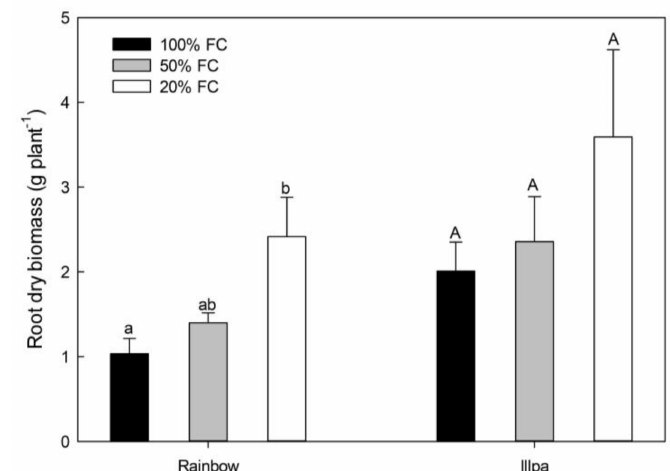
Figure 2. Root dry biomass (g plant − 1 ) in the coastal (Rainbow) and altiplano (Illpa) cultivars grown under irrigation regimes of 100% substrate holding full capacity (FC), 50% FC or 20% FC. The same letters indicate no significant di ff erences between treatments for a given cultivar ( p < 0.05). Mean ± SE ( n =